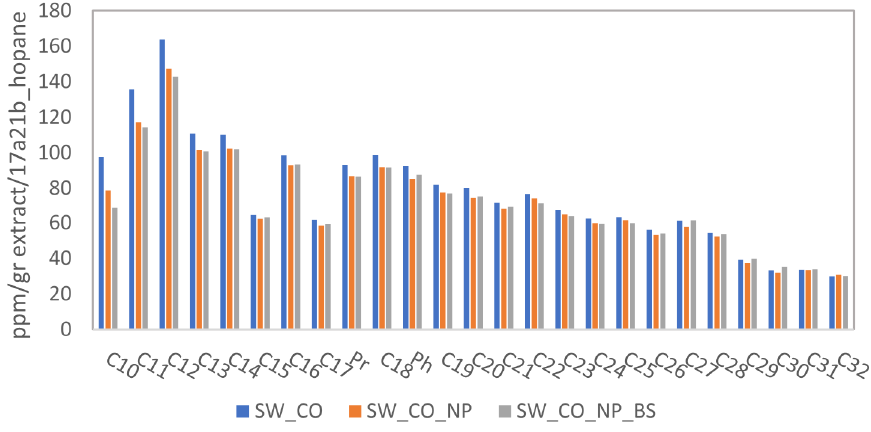
Figure A2. Bioremediation test results. Saturated hydrocarbons concentration after 7 days of bio-